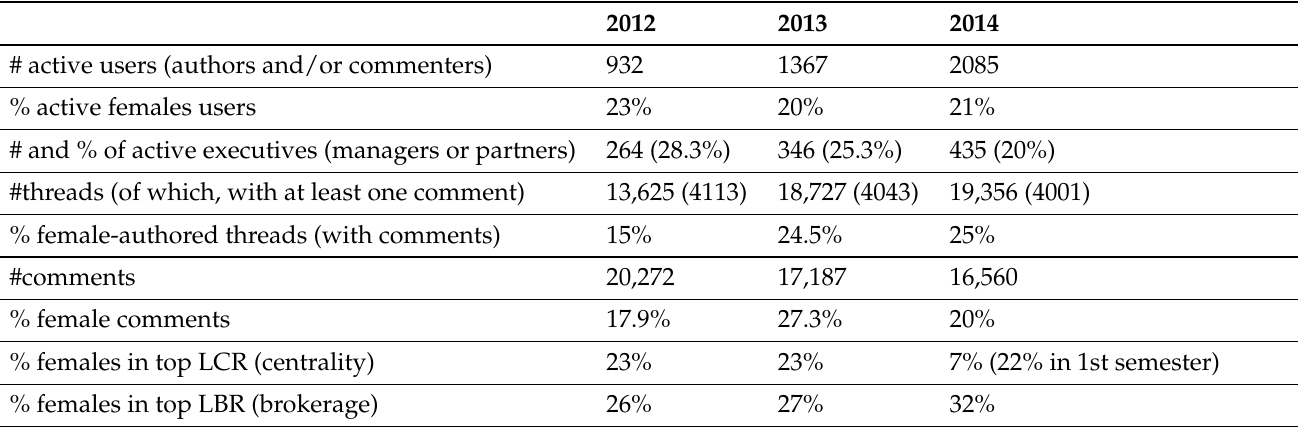
Table 2. Summary